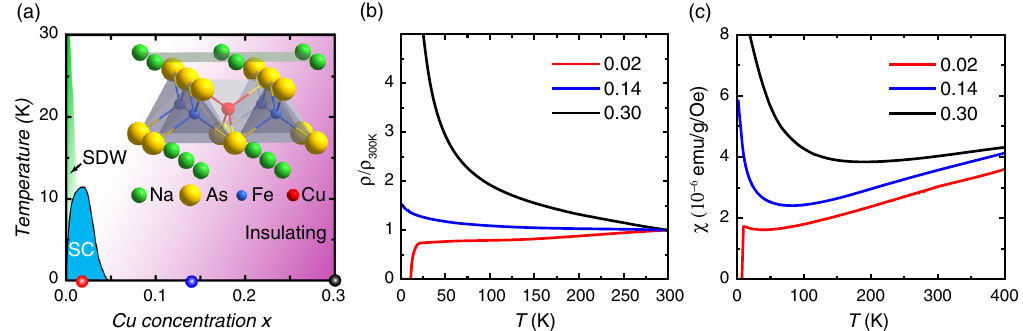
FIG. 1. (a) Schematic phase diagram of NaFe 1 − x Cu x As. Inset: The crystal structure of NaFe 1 − x Cu x As. The gray plane on the top corresponds to the exposed Na surface layer. (b),(c) Temperature dependence of the in-plane resistivity normalized by the room temperature value and the magnetic susceptibility for the three NaFe 1 − x Cu x As samples.